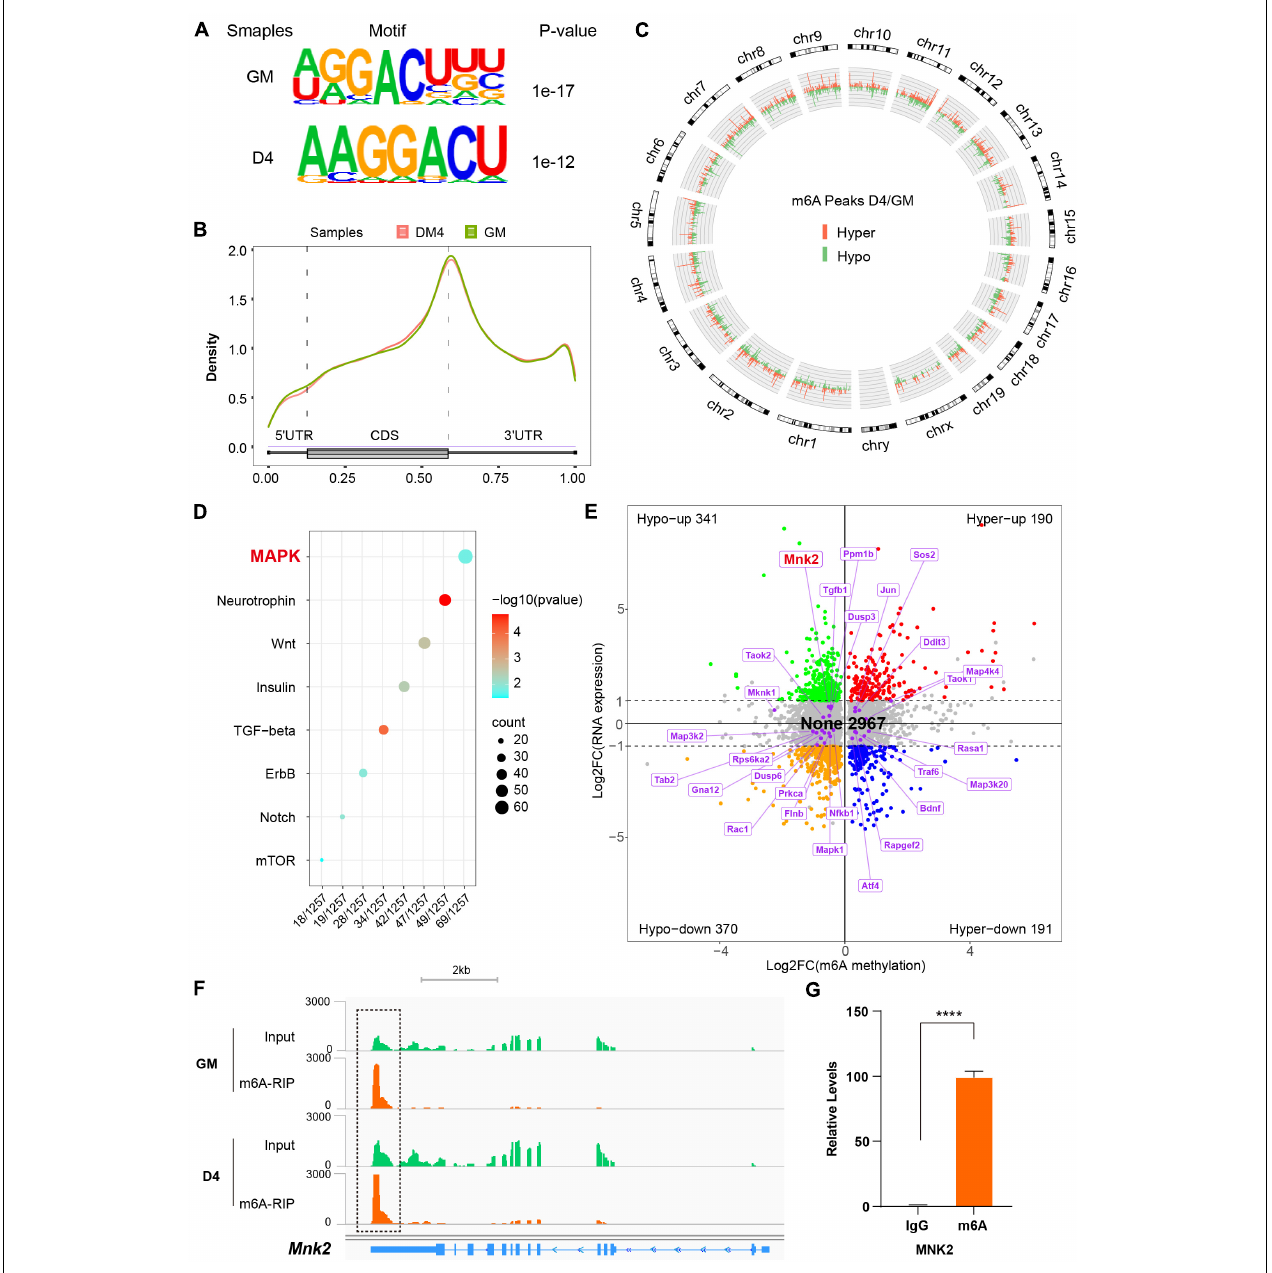
FIGURE 4 | MeRIP sequencing reveals MNK2 as an m 6 A-enriched transcript. (A) Top consensus motif identified with m 6 A peaks before (GM) and after differentiation (D4). (B) Metagene profiles of enrichment of all m 6 A peaks across mRNA transcriptome. (C) Circos analysis of the distribution of the significantly changed m 6 A peaks across the whole mouse genome. The statistical significance was FDR ≤ 0.05 (light green indicates downregulated peaks, and light orange indicates upregulated peaks). (D) KEGG enrichment analysis of signaling pathway for differentially m 6 A genes during myogenesis. (E) Distribution of genes with a significant change in both the m 6 A methylation and RNA expression levels before (GM) and after differentiation (D4), different colors were used to identified of representative genes, the none changed curve of RNA expression were defined as below twofold. (F) Integrative Genomics Viewer (IGV) plots showing methylation levels of Mnk2 gene upon differentiation (light green indicates input data, yellow orange indicates RIP data). (G) Real-time PCR detection of Mnk2 expression in immunoprecipitated RNAs. IgG Immunoprecipitation was used as negative control. Quantitative data was represented as Mean ± SD. **** p <